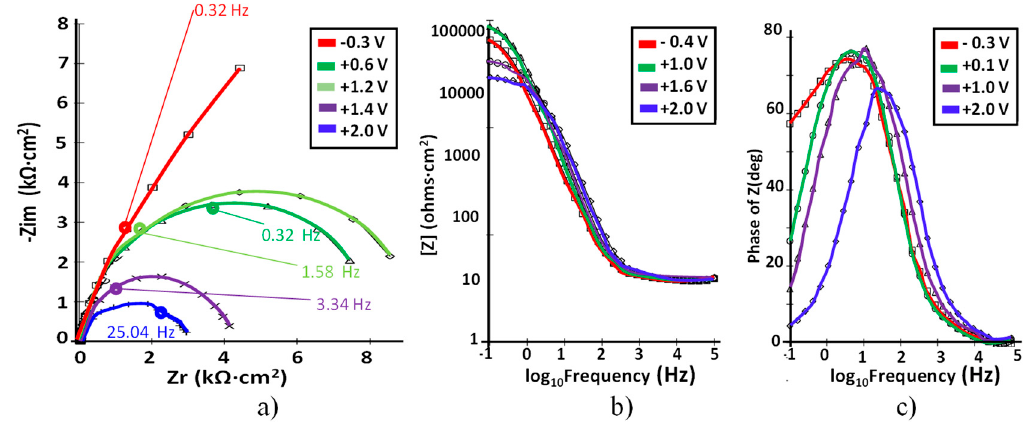
Figure 9. ( a ) Nyquist; ( b ) Bode –IZI and ( c ) Bode-phase spectra at different potentials for Ti–30Ta in simulated body fluid at pH = 7.8.